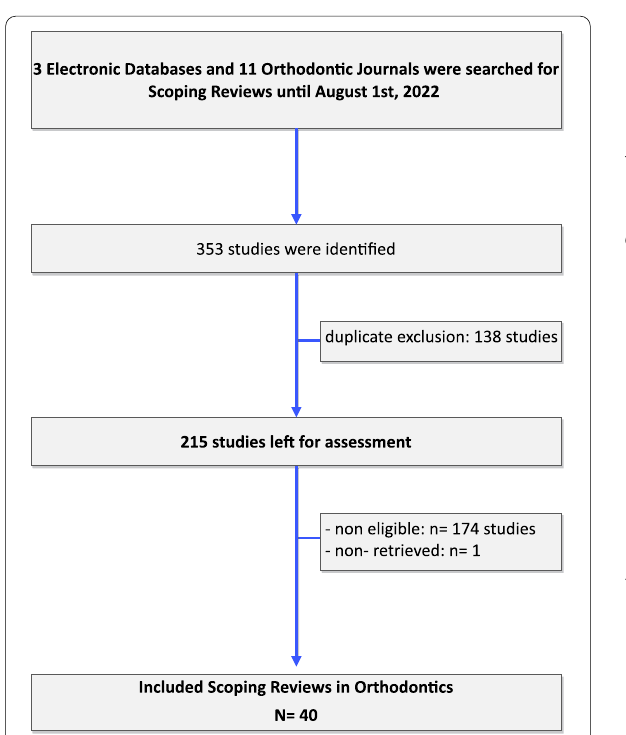
Fig. 1 Flow diagram of study selection process